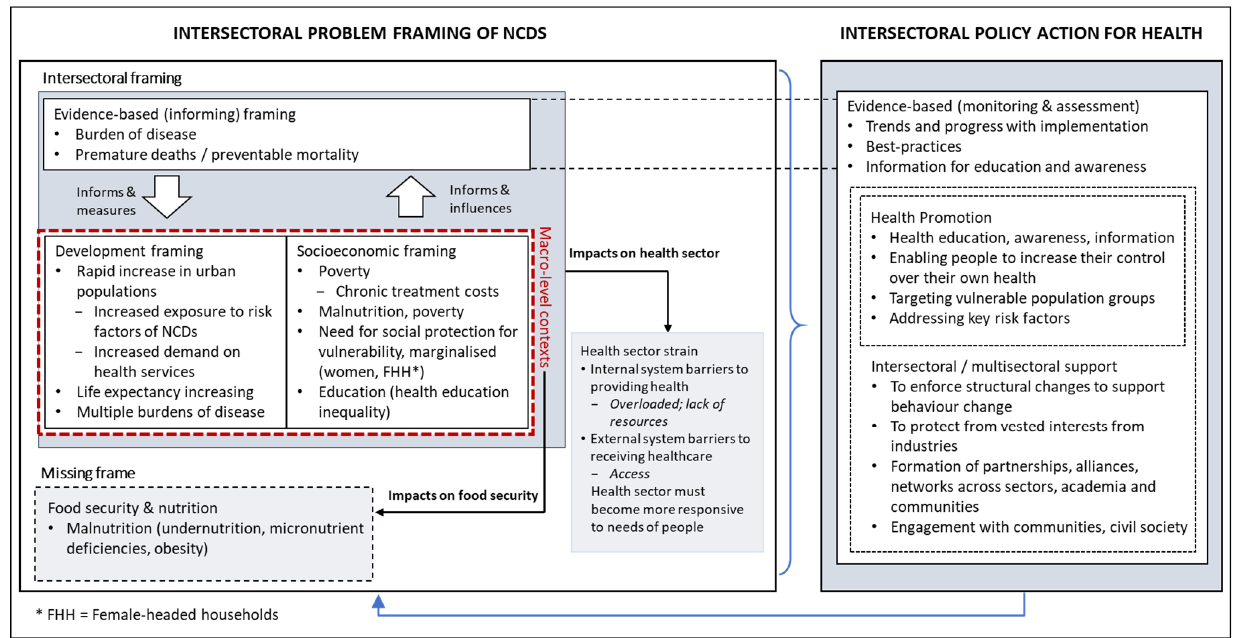
Figure 3. Conceptual framework of the African regional level frames that depicts two primary categories: the first ( left block ) comprising key frames related to NCD problem framing and the second ( right block ) highlighting approaches for policy action for health. Two of the policy problem frames ( left block ), namely ‘development’ and ‘socioeconomics’, are interrelated macro-level contexts. Regarding the intersectoral policy action for health ( right block ), health promotion is nested within intersectoral/multisectoral support, which are both supported by evidence-based monitoring and assessment. Table 2. Samples of African region policy text provided for each of the identified frames for NCD problem and solution streams. Framing Text Example Key Words